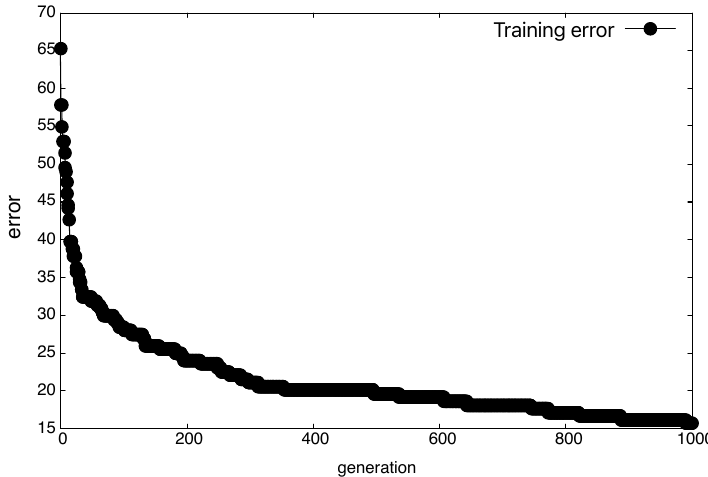
Figure A4. MEP error evolution on a training set.